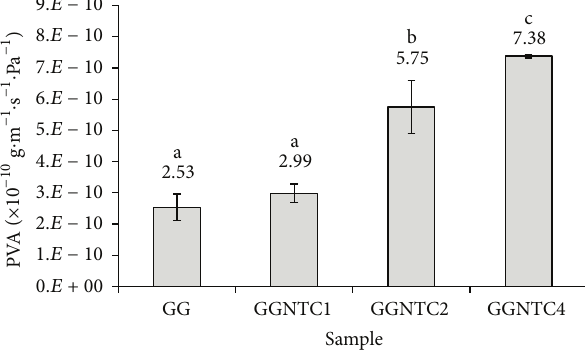
Figure 5: Water vapor permeability (WVP) of films from gelatin/glycerol and carbon nanotubes. Error bars with the same letter are not significantly different ( 𝑃 > 0.05 ).